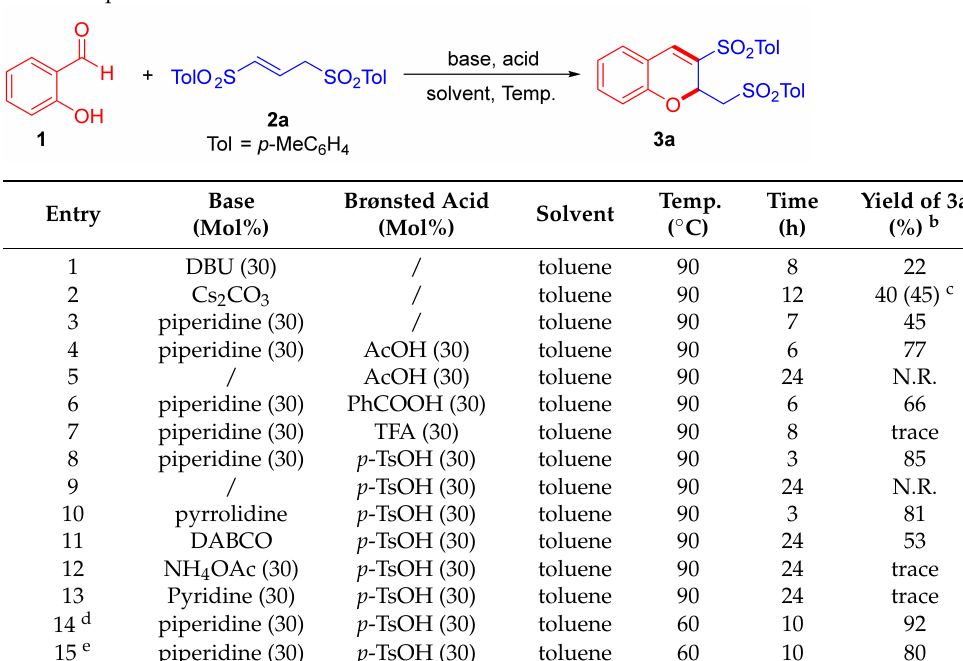
Table 1. Optimization studies a